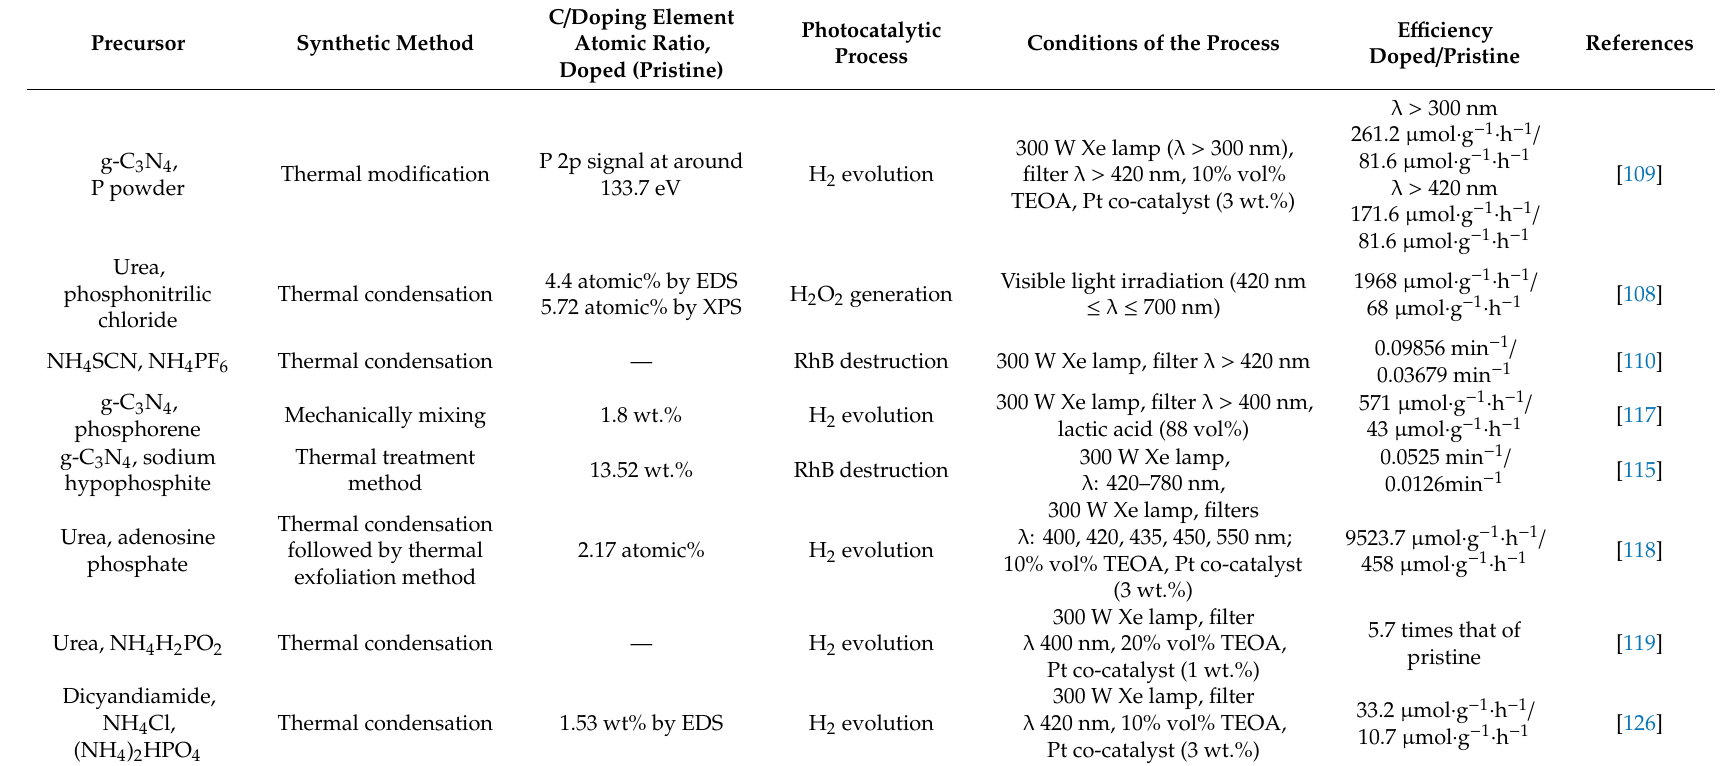
Table 5. Synthetic methods, applications, and photocatalytic e ffi ciency of P-doped g-C 3 N 4